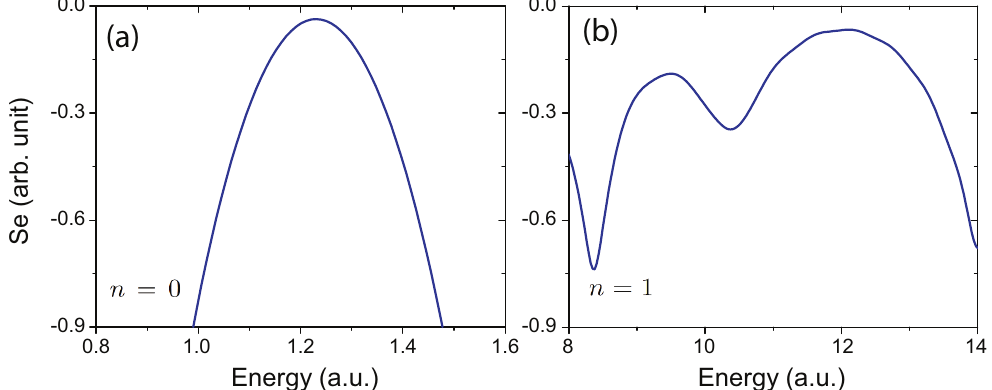
= 0 ◦ (forward scattering) of the ejected c ground 1 sσ state at equilibrium with molecular g 2 = 5 × 10 14 W/cm 2 and wavelengths ( a ) 0 = 4.0 a.u. and 1.34 a.u., respectively, e